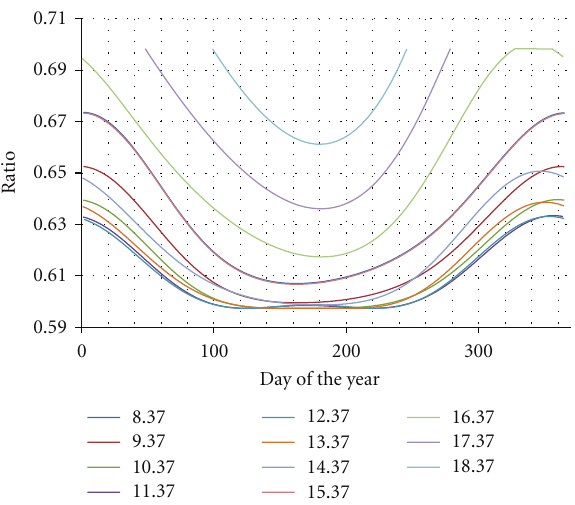
Figure 8: Ratio values of mirror 2 along the year (one-hour steps).